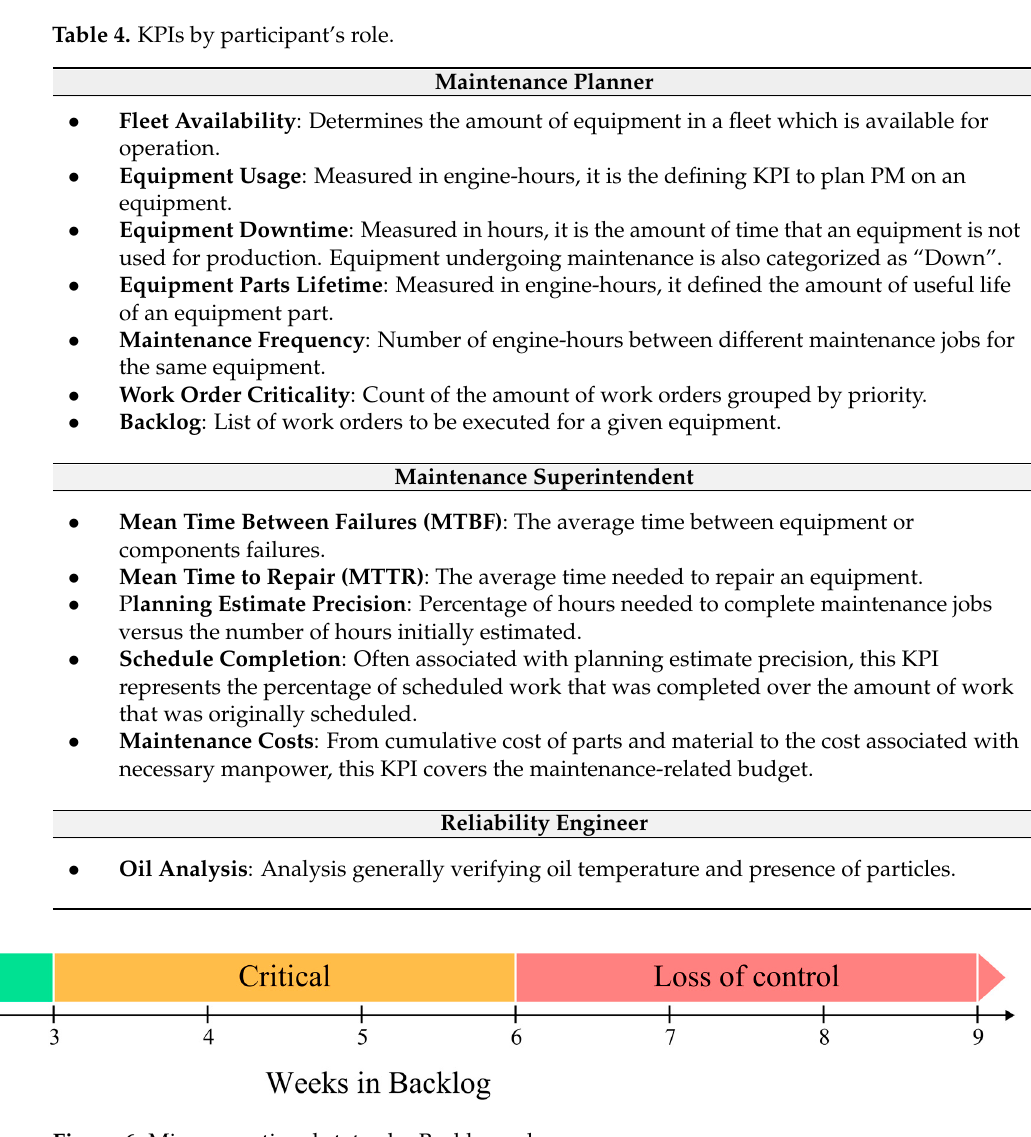
Figure 6. Mine operational status by Backlog value.